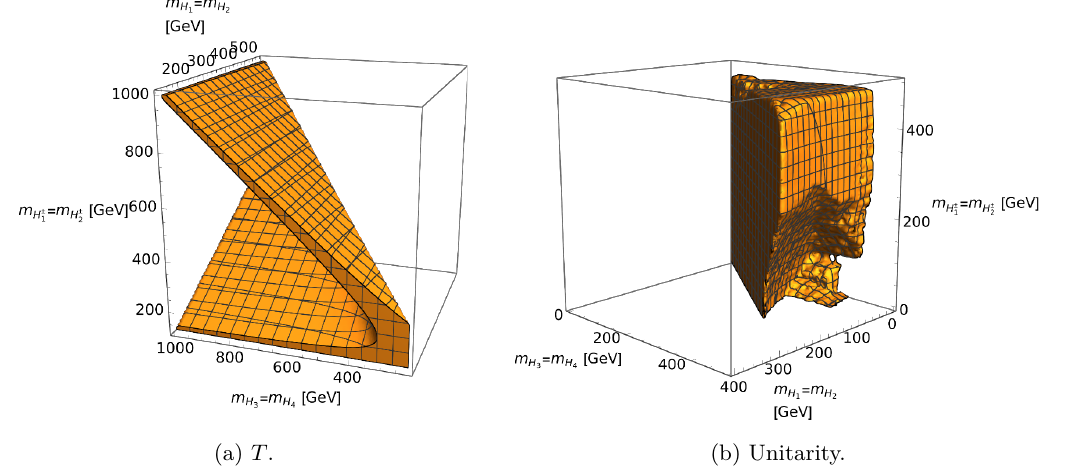
Figure 4. Regions allowed by the T -parameter at 99% level (a) and unitarity (b) for the ( ωv, v, v ) vacuum in the m H = m H vs. m H = m H vs. m = m space. The 4th free parameter, the H ± 1 H ± 2 1 2 3 4 mass of the SM-like Higgs m h , is set to 125.25 GeV. On the left panel we additionally assume that all masses are larger than m h while on the right one that they are larger than 1